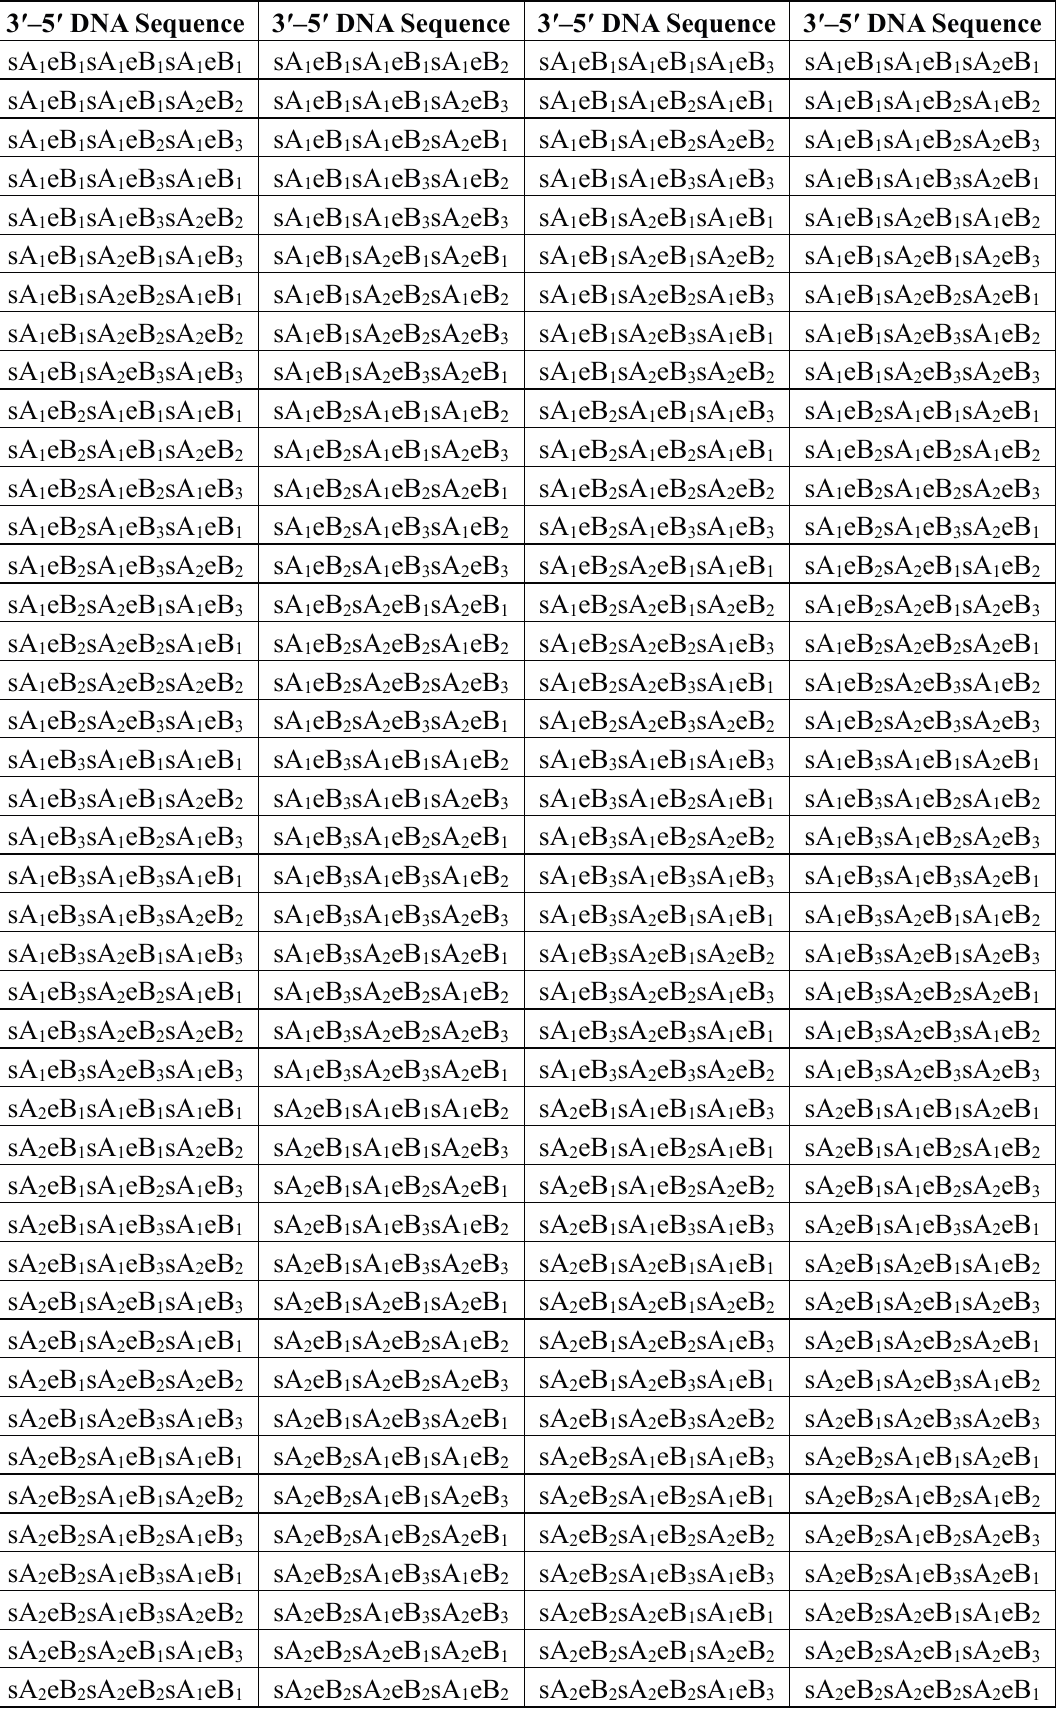
Table 3. DNA Sequences symbols after Step (1) for Table